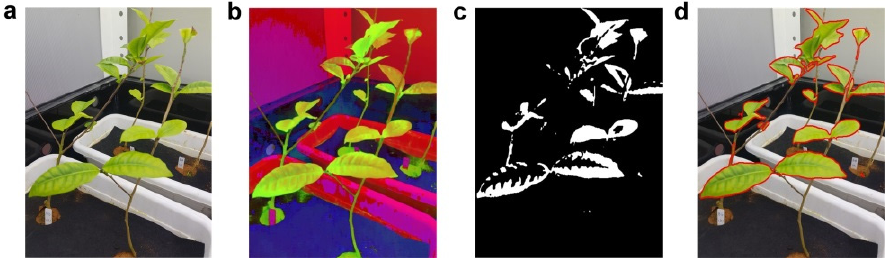
Figure 10. Image processing for the estimation of the number of leaves. ( a ) Original image. ( b ) HSV colour space. ( c ) Binarization. ( d ) Contour area of leaves.